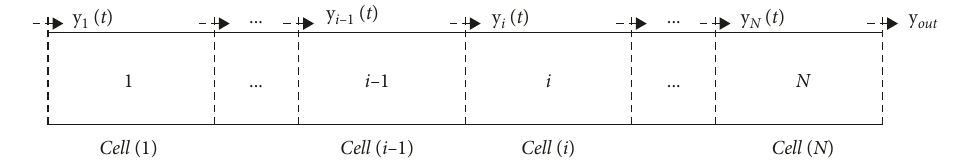
Figure 5: The principle of traffic flow propagation between cells on basic road